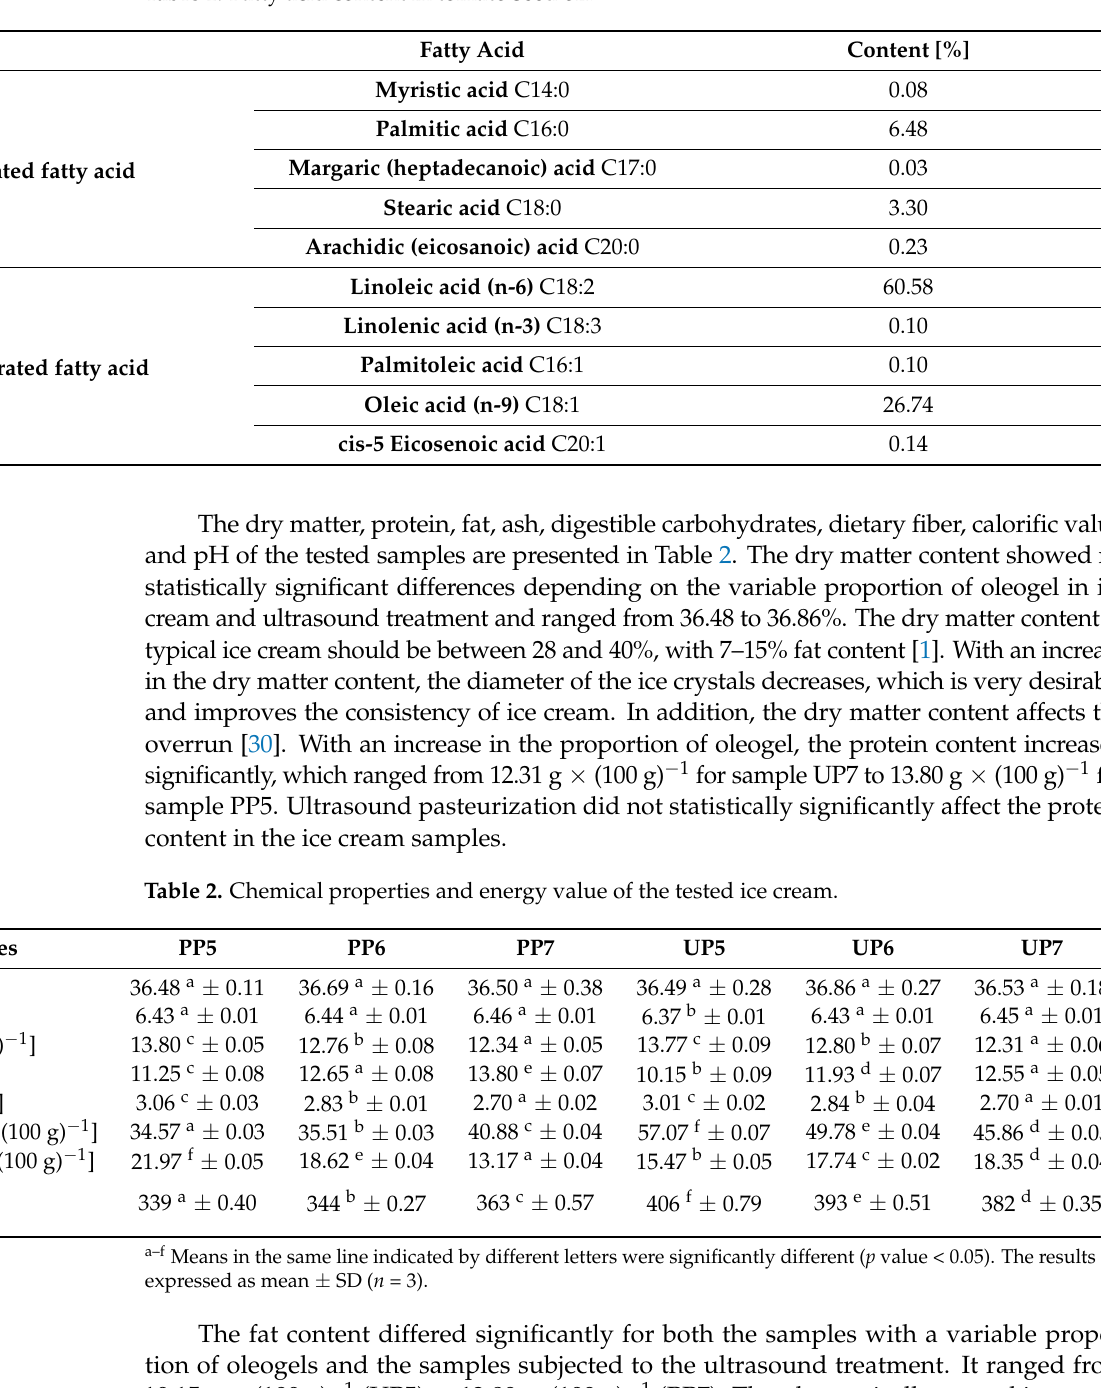
Table 1. Fatty acid content in tomato seed oil.